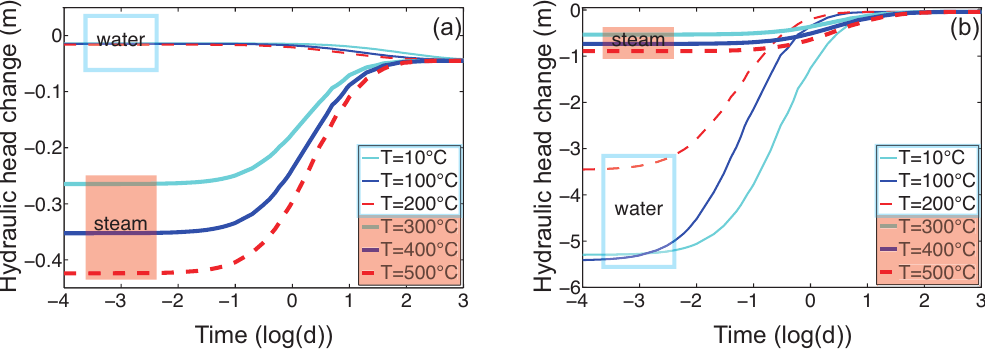
Figure 8. Central hydraulic head change and its evolution with time for different pore fluid temperatures. (a) pyroclastic aquifer, (b) lava flow